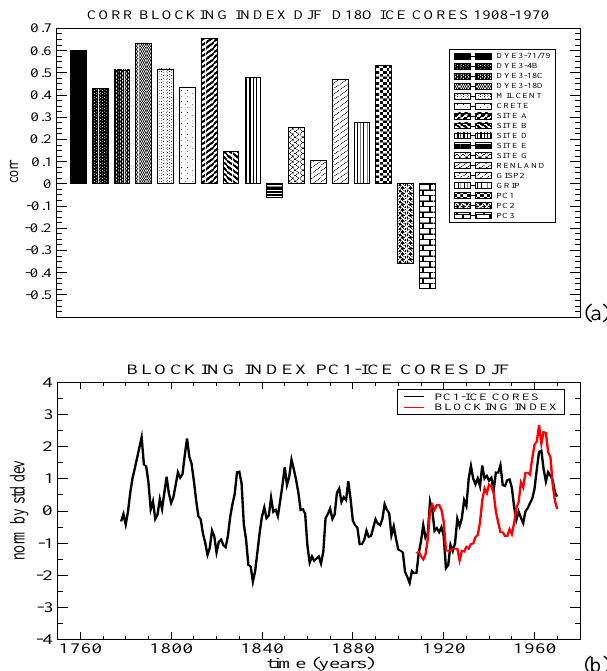
Fig. 8. (a) Correlations between winter blocking index (see text for definition) and 14 stable isotope records from Greenland as well as their PC1, PC2 and PC3 (Vinther et al., 2010) for the period 1908– 1970. (b) Filtered (7-year running mean) PC1 of stable isotopes (black) and blocking index